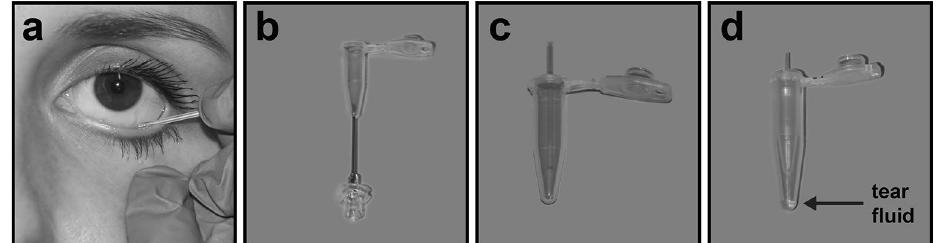
Figure 1. Tear fluid collection with plastic capillary tubes. ( a ) An end-to-end plastic capillary tube with a capacity of 10 μl is placed at the lower conjunctival fornix until the desired volume of tear fluid is collected utilizing capillary action. ( c ) The capillary is transferred to a punctured 0.5 ml tube ( b ) and ( d ) centrifuged into a 1.5 ml tube in order to retrieve the tear